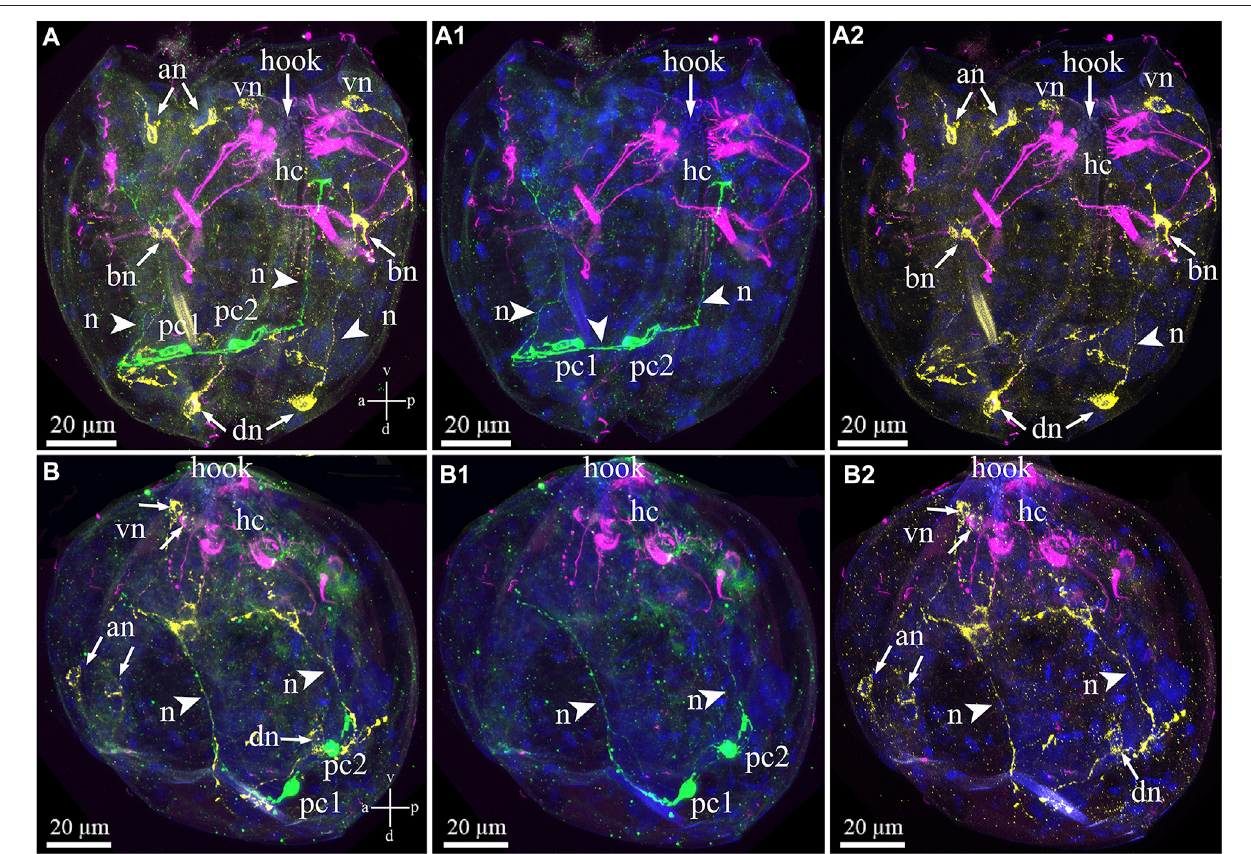
FIGURE8| Doublestainingof5-HT/FMRFa-lirnervouselementscombinedwithtubulinimmunoreactivityofhaircellsinthe Nodulariadouglasiae glochidia. (A – A2) posterior view; (B – B2) lateral view.Yellow — FMRFa-lir; magenta — hair cells,green — serotonin, and blue — nuclei,DAPI. (A, B) Triplestaining(FMRFa-lir/haircells/5-HT); (A1, B1) double staining (hair cells/5-HT); (A2,B2) double staining (hair cells/FMRFa-lir); (A,B) 5-HT-lir posterior neurons and FMRFa-lir neurons are not colocalized as well as 5-HT-lir posterior neurons are not colocalized tubulin. Colocalization of immunostaining was detected only in combination FMRFa-lir/hair cells and only in base cells (neurons). The 5-HT-lir cells are connected to each other by neurites (arrowheads), and FMRFamidergic neurons connect with each other. (A,B) Vertical v-d labelled line refers to ventro-dorsal body axes and horizontal line a-p labelled line refers to anterior-posterior body axes of larva. Abbreviations: an, anterior neurons; bn, basal neurons; dn, dorsal neurons; hc, hair cells; n, neurites, pc, posterior cells; vn, ventral neurons . Scale bars, (A – B2) , 20 μ m.